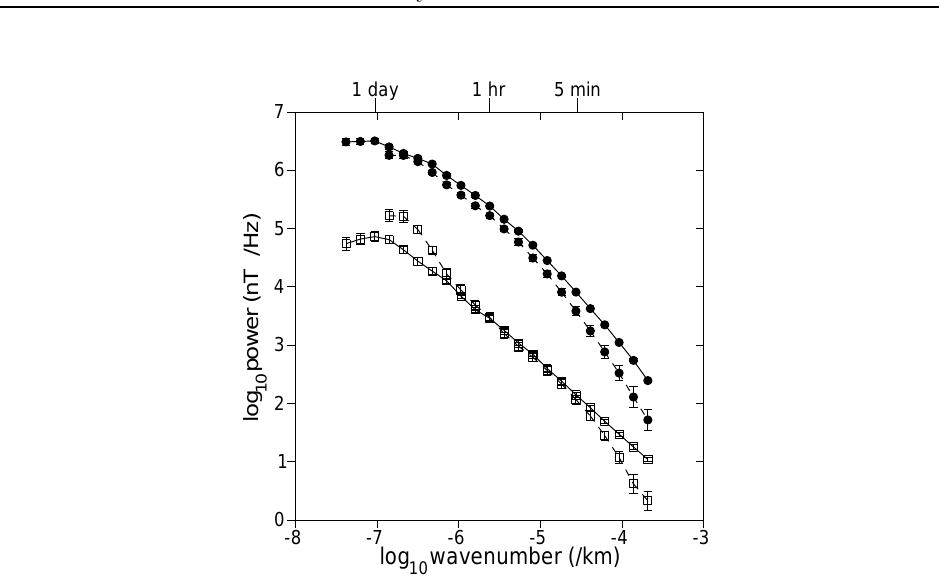
Figure 60: Power spectra of magnetic field components (solid circles) and magnitude (open squares) from Ulysses (solid line) and Helios 1 (dashed line). Spectra have been extrapolated to 1 AU using radial trends in power scalings estimated from Ulysses between 1.4 and 4.1 AU and Helios between 0.3 and 1 AU. Image reproduced by permission from Horbury and Balogh (2001), copyright by